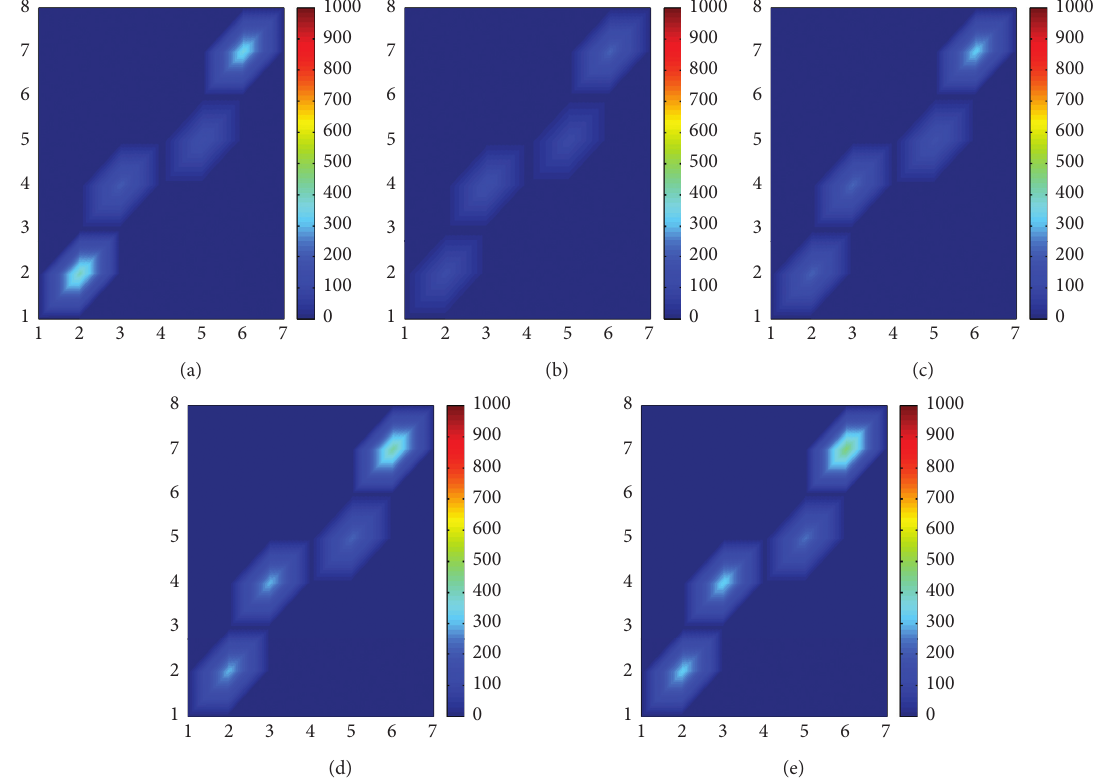
Figure 8: The biomass of middle predator behavior within Ω with control u C pq . (a) t � 0. (b) t � 50. (c) t � 100. (d) t � 150. (e) t �